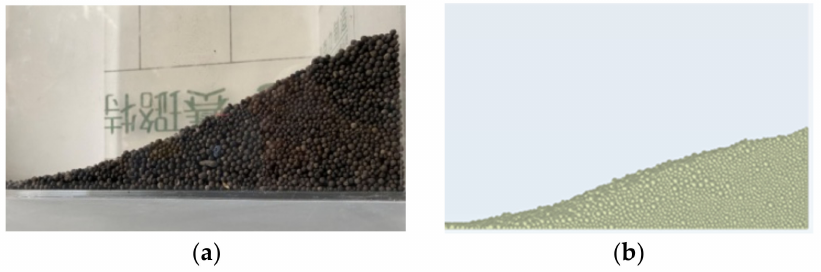
Figure 10. Calibration of angle of repose for granular fungal fertilizers: ( a ) actual test; ( b ) simulation